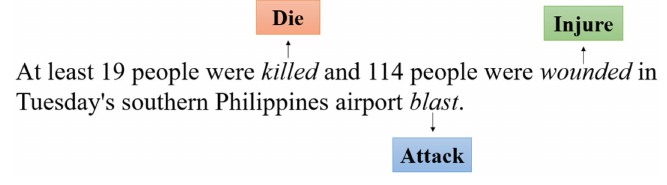
Figure 1. An example sentence of the ACE2005